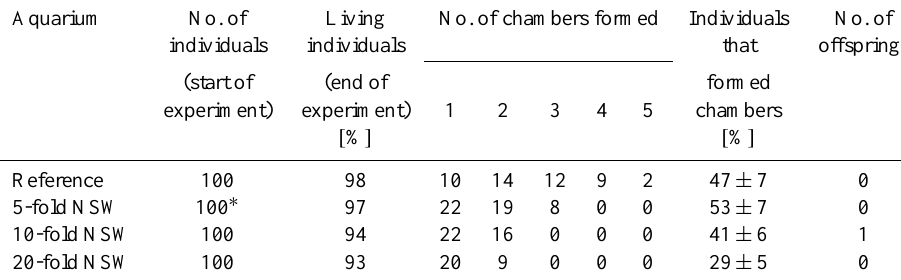
Table 2. Chamber addition of the cultured foraminifera.